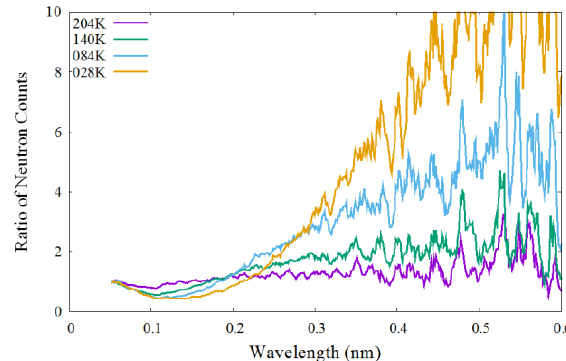
Fig. 3. Relative neutron intensity for some temperature comparing to that for 251K.